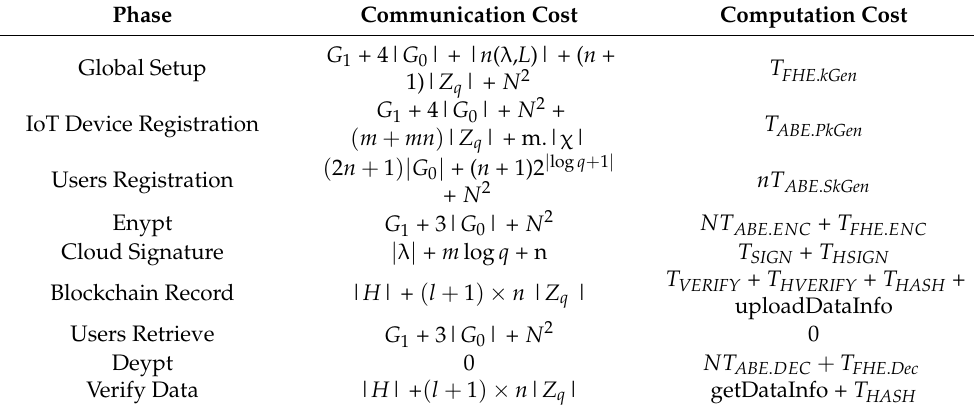
Table 5. Communication and computation cost(s) of IoT data sharing.